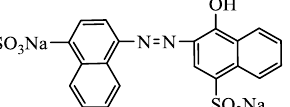
Figure 3 . Relationship between dosage of Sr FeMoO and decolorization rate. 2 6